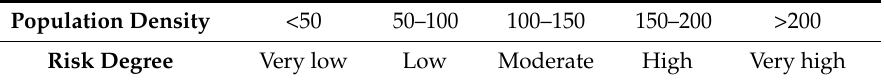
Table 4. Classification of the population density categories.